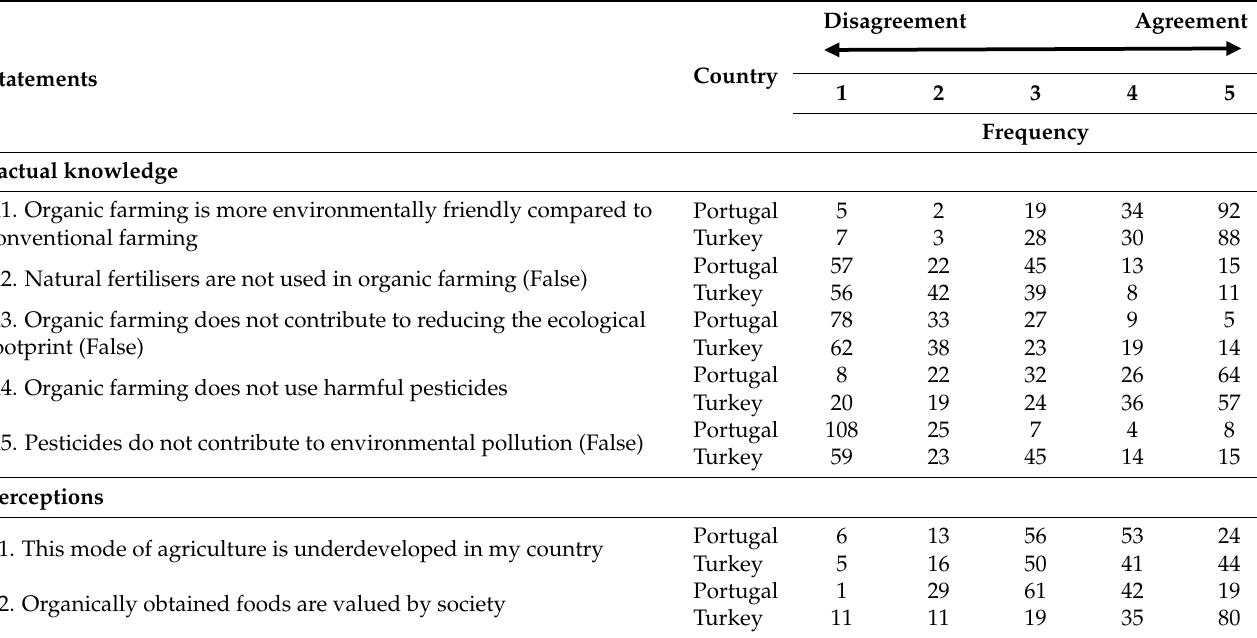
Table 6. Knowledge and perceptions about the impact of organic foods.